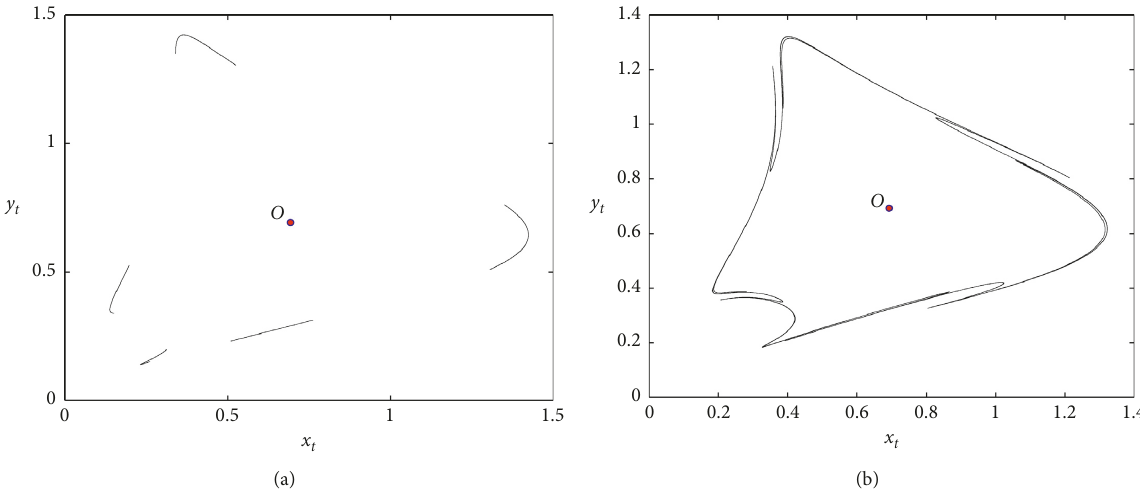
Figure 6: It represents two different dynamic situations, (a) Five chaotic attractors at k � 1 . 4 and ω � 0 . 413. (b) A strange attractor k � 1 . 4 and ω � 0 . 449. Other parameters are a � 1 ,c � 0 .